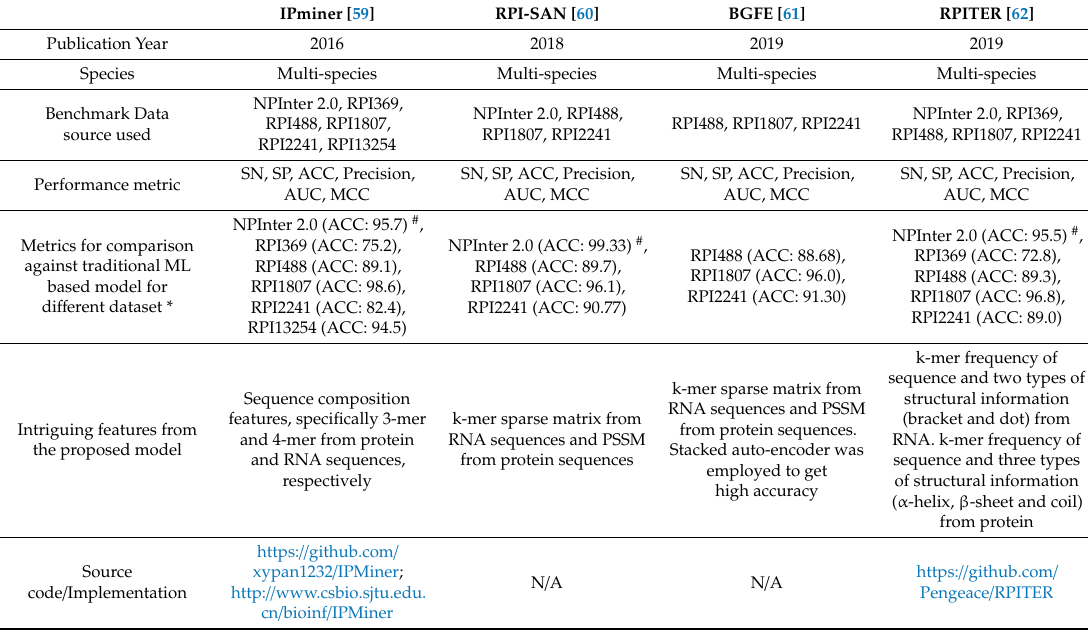
Table4. OverviewofarticlesforlncRNA–proteininteractionpredictionleveragingDL-basedtechniques. IPminer [59] RPI-SAN [60] Multi-species Multi-species Multi-species Multi-species